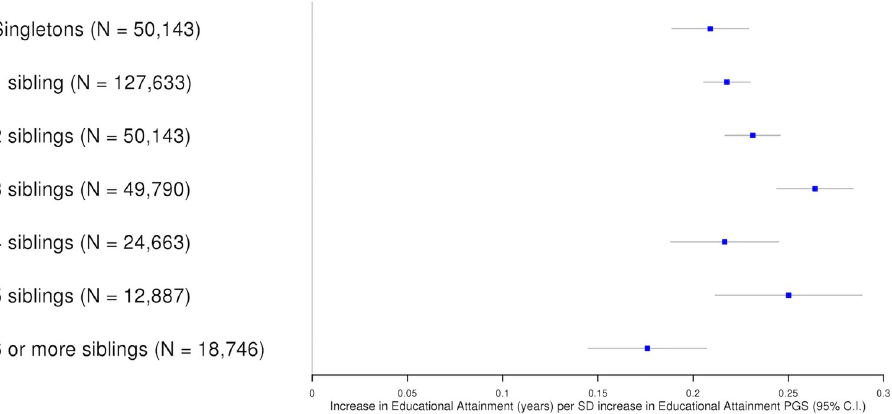
Fig 4. Educational attainment PGS and years in schooling by number of siblings. Fig 4 displays association estimates between educational attainment PGS and educational attainment stratified by the number of self-reported siblings. Individuals reporting 6 or more siblings were combined into the same